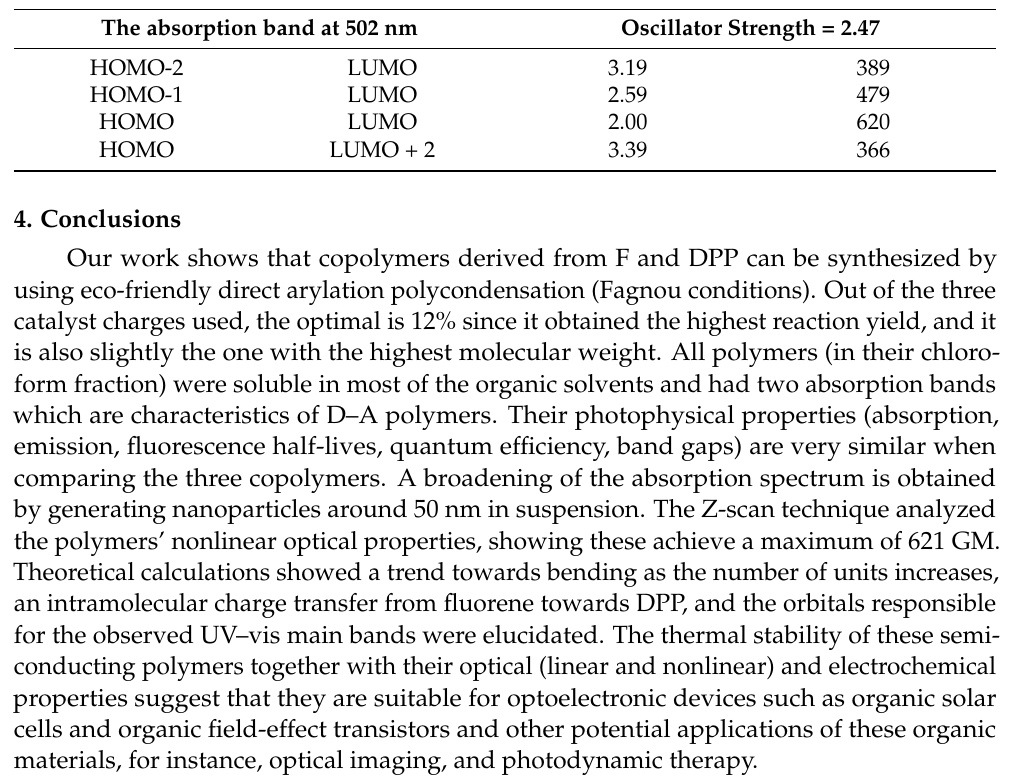
family of polymers; Figure S1: 1 H NMR spectra of PFDPP-2 in CDCl 3 ; Figure S2: 1 H NMR spectra of PFDPP-3 in CDCl 3 ; Figure S3: Molecular weight distribution of PFDPP-1 ; Figure S4: Molecular weight distribution of PFDPP-2 ; Figure S5: Molecular weight distribution of PFDPP-3 ; Table S2: Fitting of lifetime fluorescence of the PFDPP polymers; Figure S6: Cyclic voltammograms of PFDPP-2 film polymer (oxidation left and reduction right); Figure S7: Cyclic voltammograms of PFDPP-3 film polymer (oxidation left and reduction